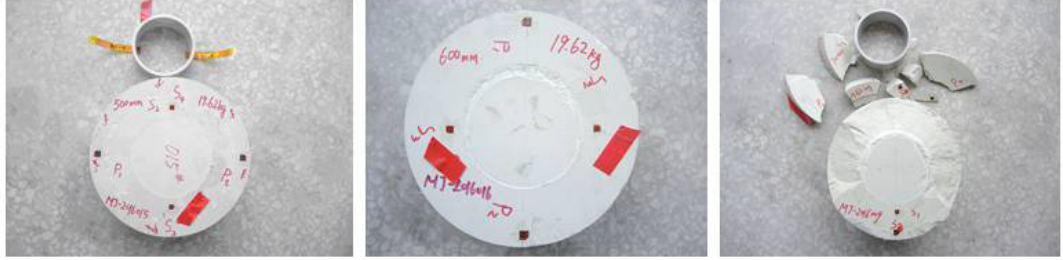
Figure 7. Morphology of PBX simulation material after drop test.